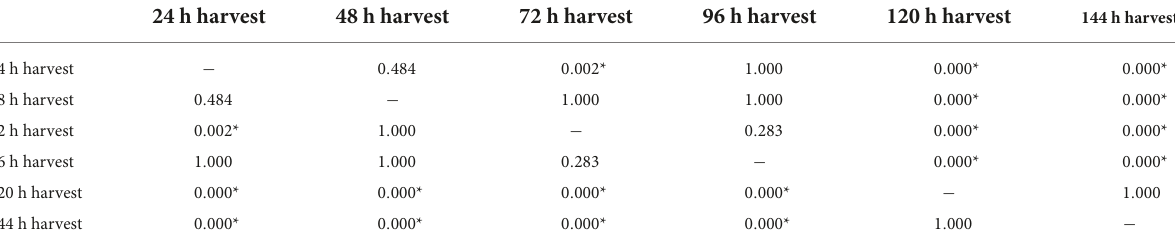
TABLE 10 Pairwise comparison of the harvests for NO by Scheffe post hoc